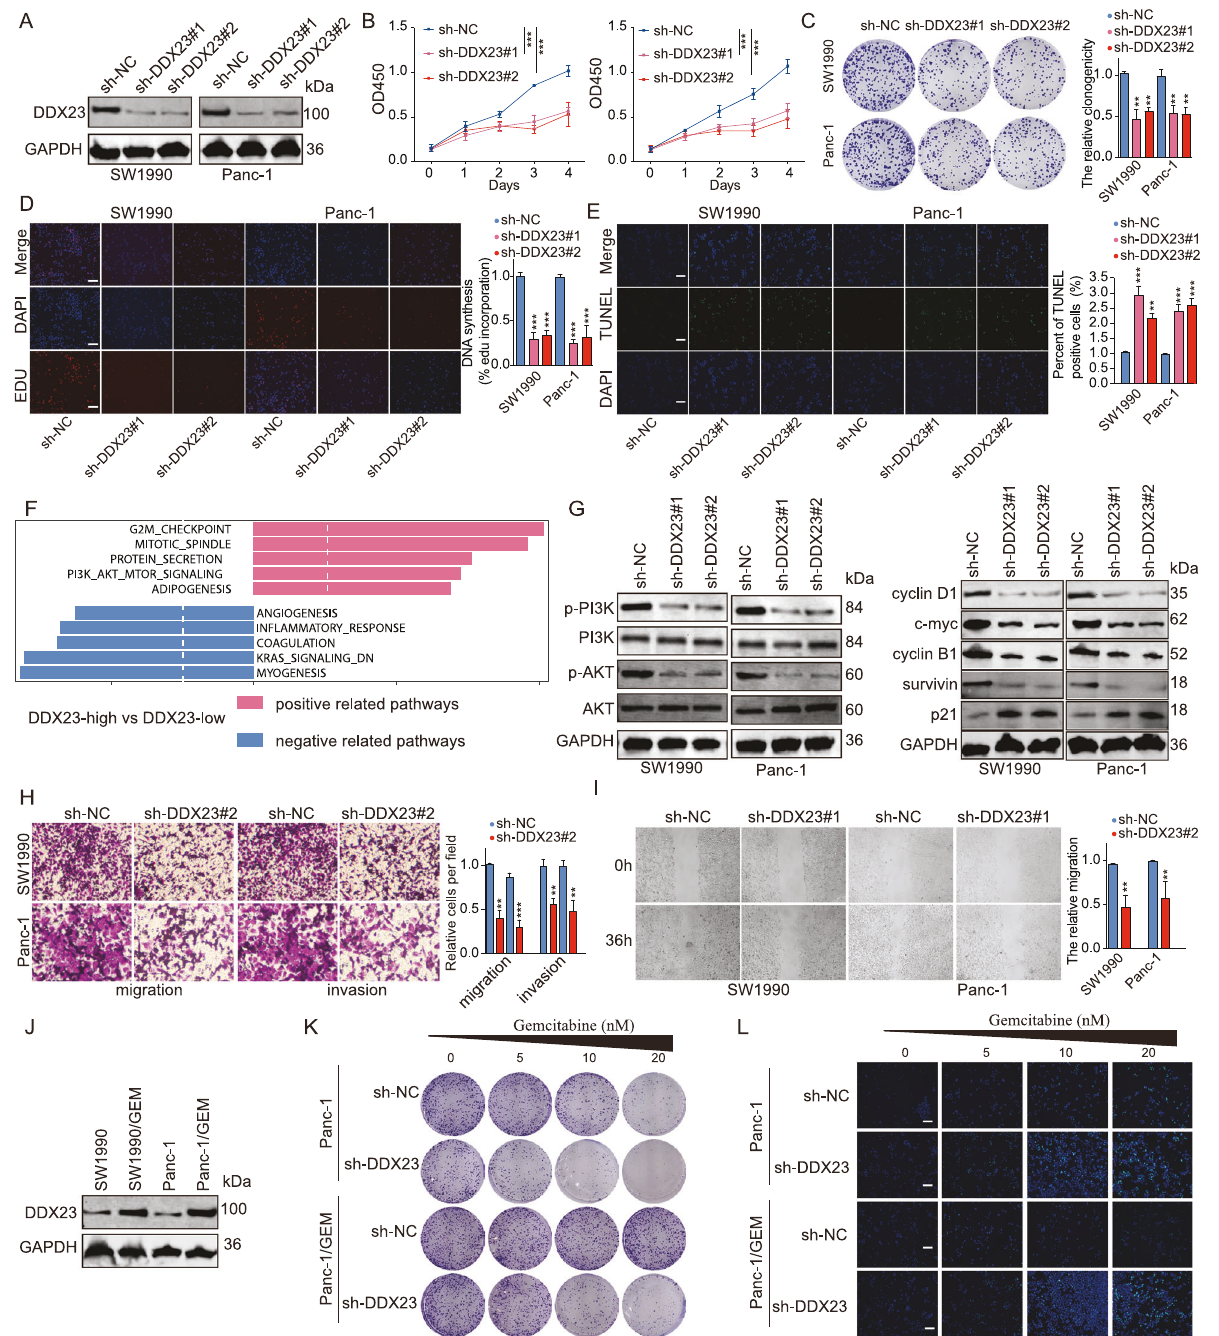
Fig. 5 The knockdown of DDX23 signi fi cantly suppressed the proliferation, migration, invasion as well as resistance to gemcitabine of pancreas cancer cells via PI3K/Akt signaling. A The two shRNAs against DDX23 signi fi cantly suppressed the expression of DDX23 protein. B In the CCK8 assay, DDX23 knockdown inhibited the optical density (OD) at 450 nm in the two cell lines. C , D In colony formation assay ( C ) and EDU incorporation assay ( D ), DDX23 silence suppressed the proliferation of the two cell lines. E In the TUNEL assay, the knockdown of DDX23 led to a signi fi cantly higher TUNEL positive cell proportion. F The signaling pathway correlation analysis result showed that DDX23 expression was positively correlated with G2M checkpoint, mitotic spindle, protein secretion, PI3K/Akt signaling, and adipogenesis, and negatively correlated with angiogenesis, in fl ammatory response, coagulation, KRAS signaling, and myogenesis. G The knockdown of DDX23 led to signi fi cantly inhibited p-PI3K, p-Akt, cyclin D1, c-myc, cyclin B1, survivin levels but increased p21 expression in the two cell lines. H In the Transwell assay, DDX23 knockdown led to the suppression of migration and invasion of both cell lines. I In wound healing assay, DDX23 silence resulted in the suppression of cell migration in 36 h. J In GEM-resistant cell lines, DDX23 was signi fi cantly upregulated. K DDX23 knockdown led to suppressed cell growth in the Panc-1 cell line and GEM-resistant Panc-1 cell line. L In the TUNEL assay, DDX23 knockdown resulted in signi fi cantly enhanced TUNEL positivity in the Panc-1 cell line and GEM-resistant Panc-1 cell line. ** P < 0.01, *** P < 0.001, compared with the sh-NC